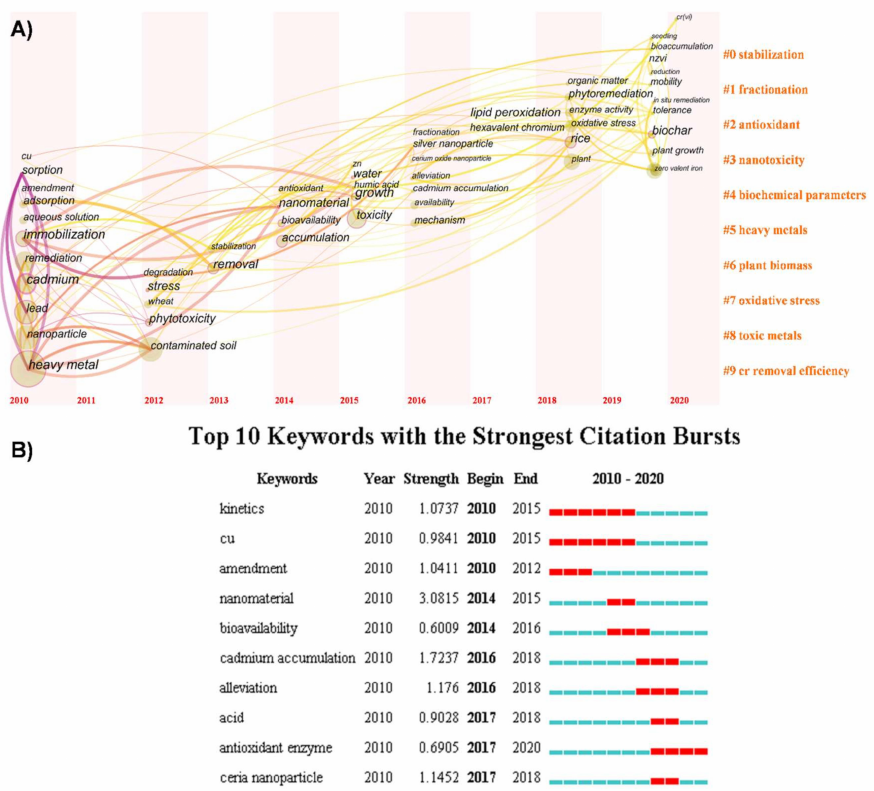
Figure 2. ( A ) Time-zone chart of high frequency keywords and clustering of keywords from January 2010 to November 2020. Node location indicates the time of keywords first appear and the size of node indicates the frequency of keyword occurrence in the studied documents. The orange font on the right shows the clustering results of keywords, indicating some research topics. ( B ) Top10 keywords with the strongest citation bursts. Strength represents the amount of a particular keyword being cited over a period of time, which indicates the most active area of research. Red bars indicate the start and end of a particular keyword citation